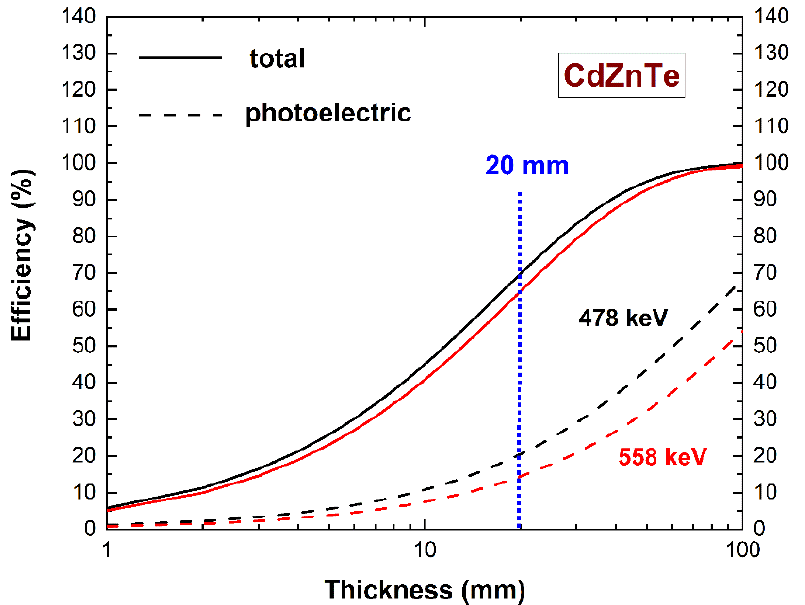
Figure 2. Calculated detection efficiency versus CZT material thickness. The energies are the typical gamma energies of the 10 B(n, α ) 7 Li and 113 Cd(n, γ ) 114 Cd reactions.